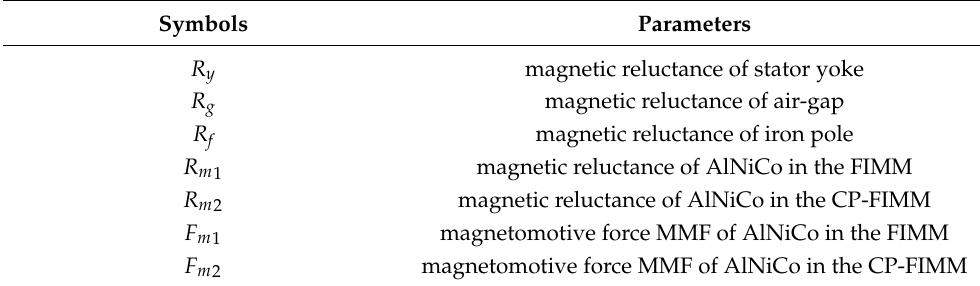
Table 2. Parameters in equivalent magnetic circuits.